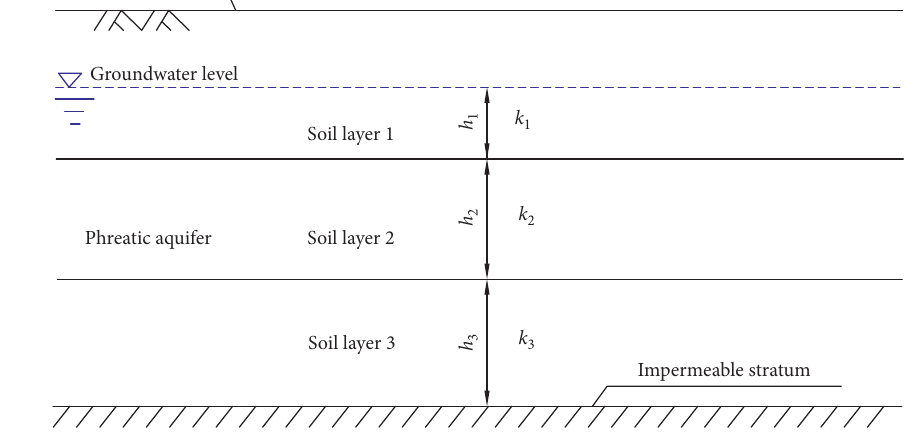
Figure 5: Geological conditions of multilayered